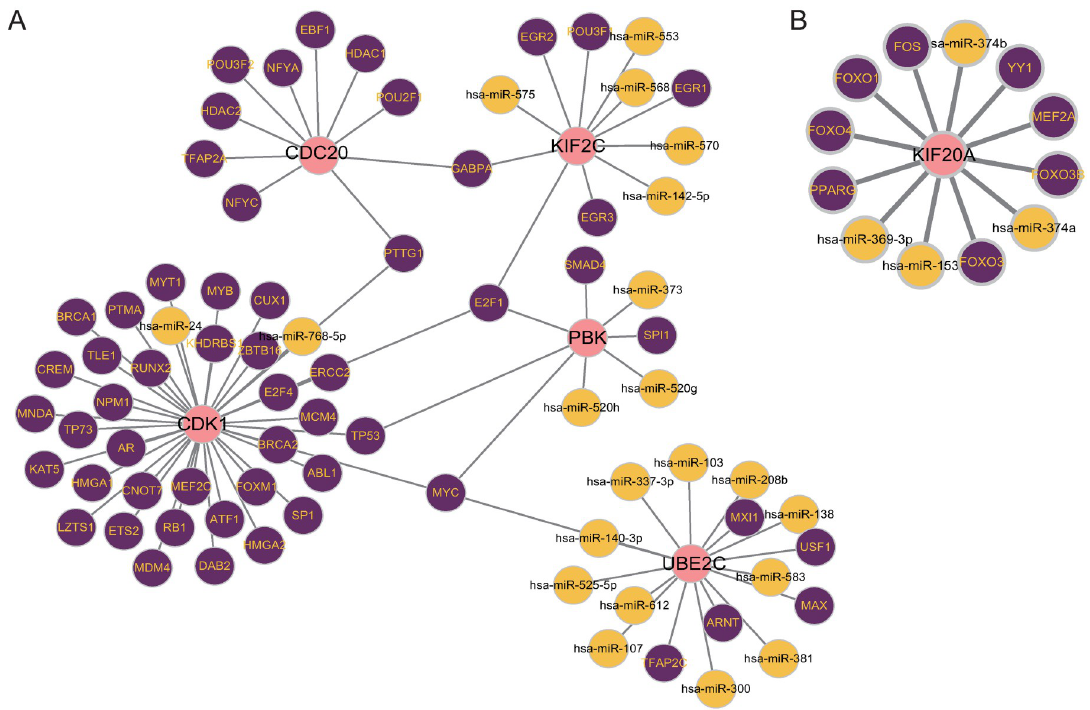
Fig 8. Transcription factors-miRNA-gene regulatory networks in COVID-19 myocarditis. There were two TF-miRNA networks. Pink plots represent critical genes, purple plots represent TF genes, and the others represent miRNAs. Network (A) had 83 plots and 85 edges, which was consisted of 5 critical genes, 56 TF genes, and 21 miRNAs. Network (B) had 13 plots and 12 edges including 1 critical gene, 8 TF genes, and 4 miRNAs.